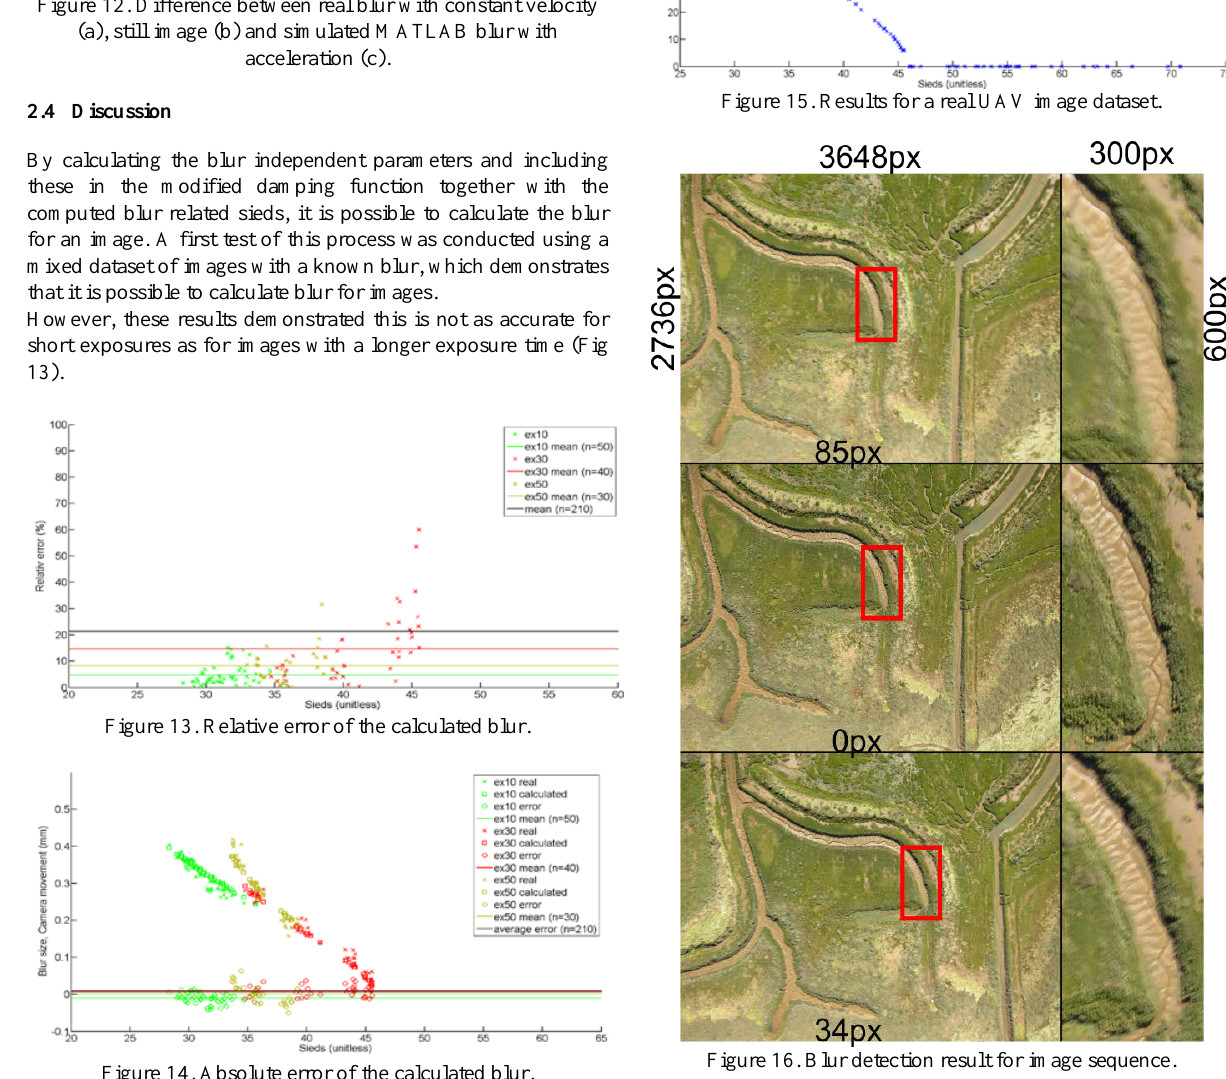
Figure 14. Absolute error of the calculated blur.